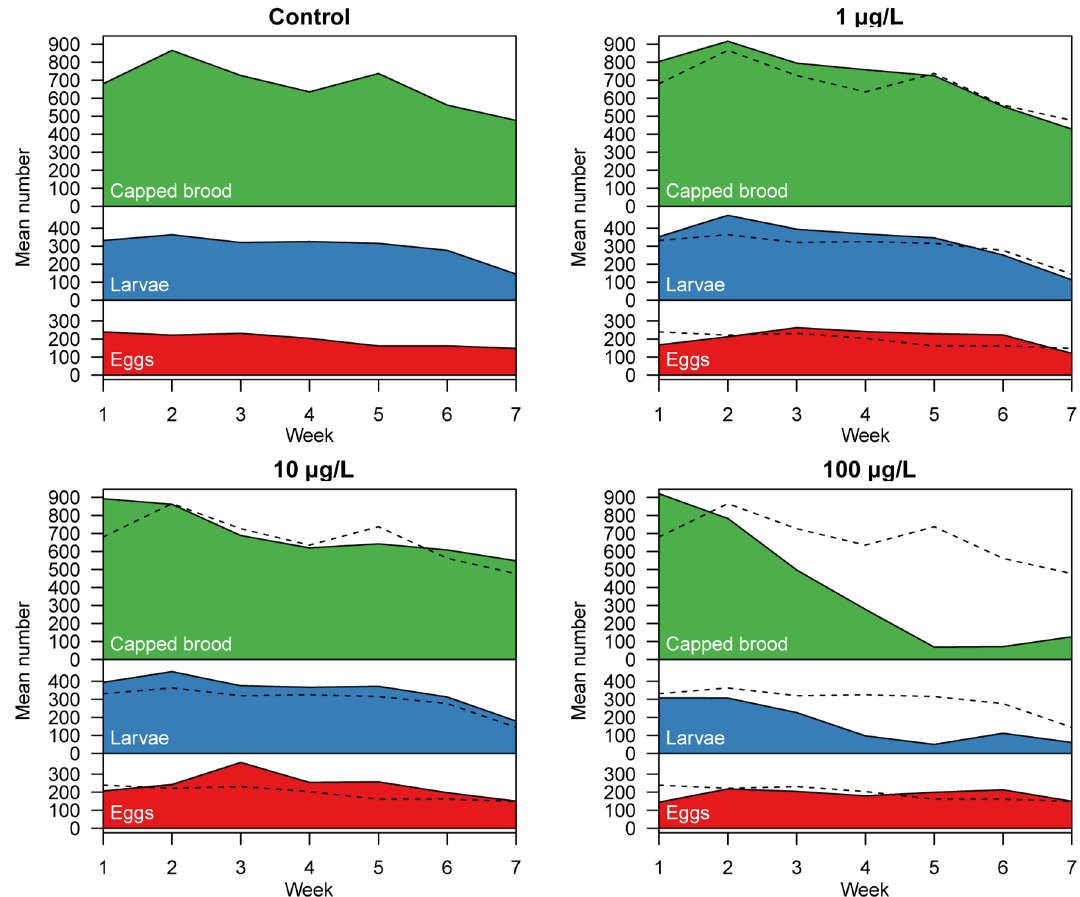
Figure 4. Brood quantification. Every week, the mean number of eggs (red), larvae (blue), and pupae (green) was determined for every colony over a period of 7 weeks. The black dashed line depicts the mean values of the control. In colonies exposed to lower or medium concentrations of clothianidin, the mean number of eggs, larvae or capped brood were similar or tended to exceed the numbers of the control group. The trends for the eggs, larvae, and capped brood cells all differed significantly between the treatment groups (main effects of quadratic time and their interaction with treatment in linear mixed-effects models, P < 0.001 in all cases). Pairwise comparisons showed that the temporal profiles of eggs differed significantly from the control for all clothianidin doses ( P < 0.03 in all cases), and that for larvae and capped brood cells only the 100 µg/L group differed significantly from the control. Weeks 6 and 7 were already in September, thus a seasonally related drop in brood nest size was observed at the end of the experiment. Raw data and technical details of the analysis are provided in the supplementary statistical report, “HPTLC analysis of worker jelly and larvae”